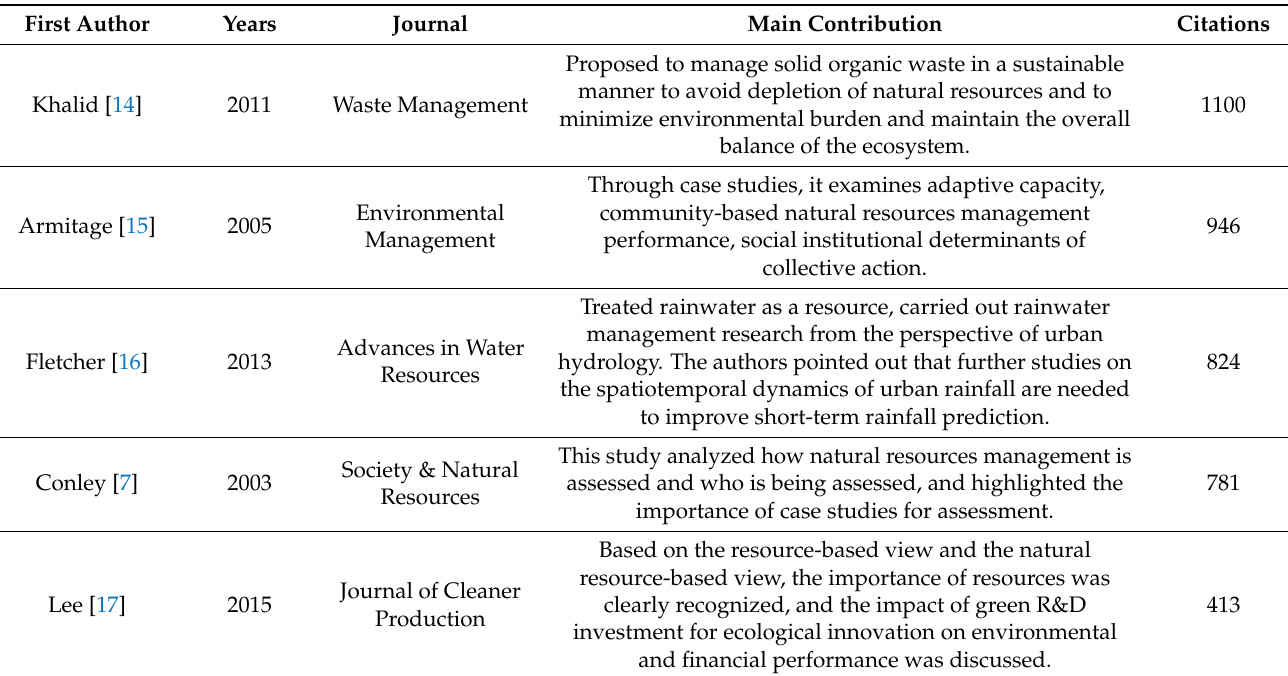
Figure 2. Keyword co-occurrence timeline graph of performance management of natural resources research from 1990 to 2021. Table 2. High-cited literature on research on performance management of natural resources from 1990 to